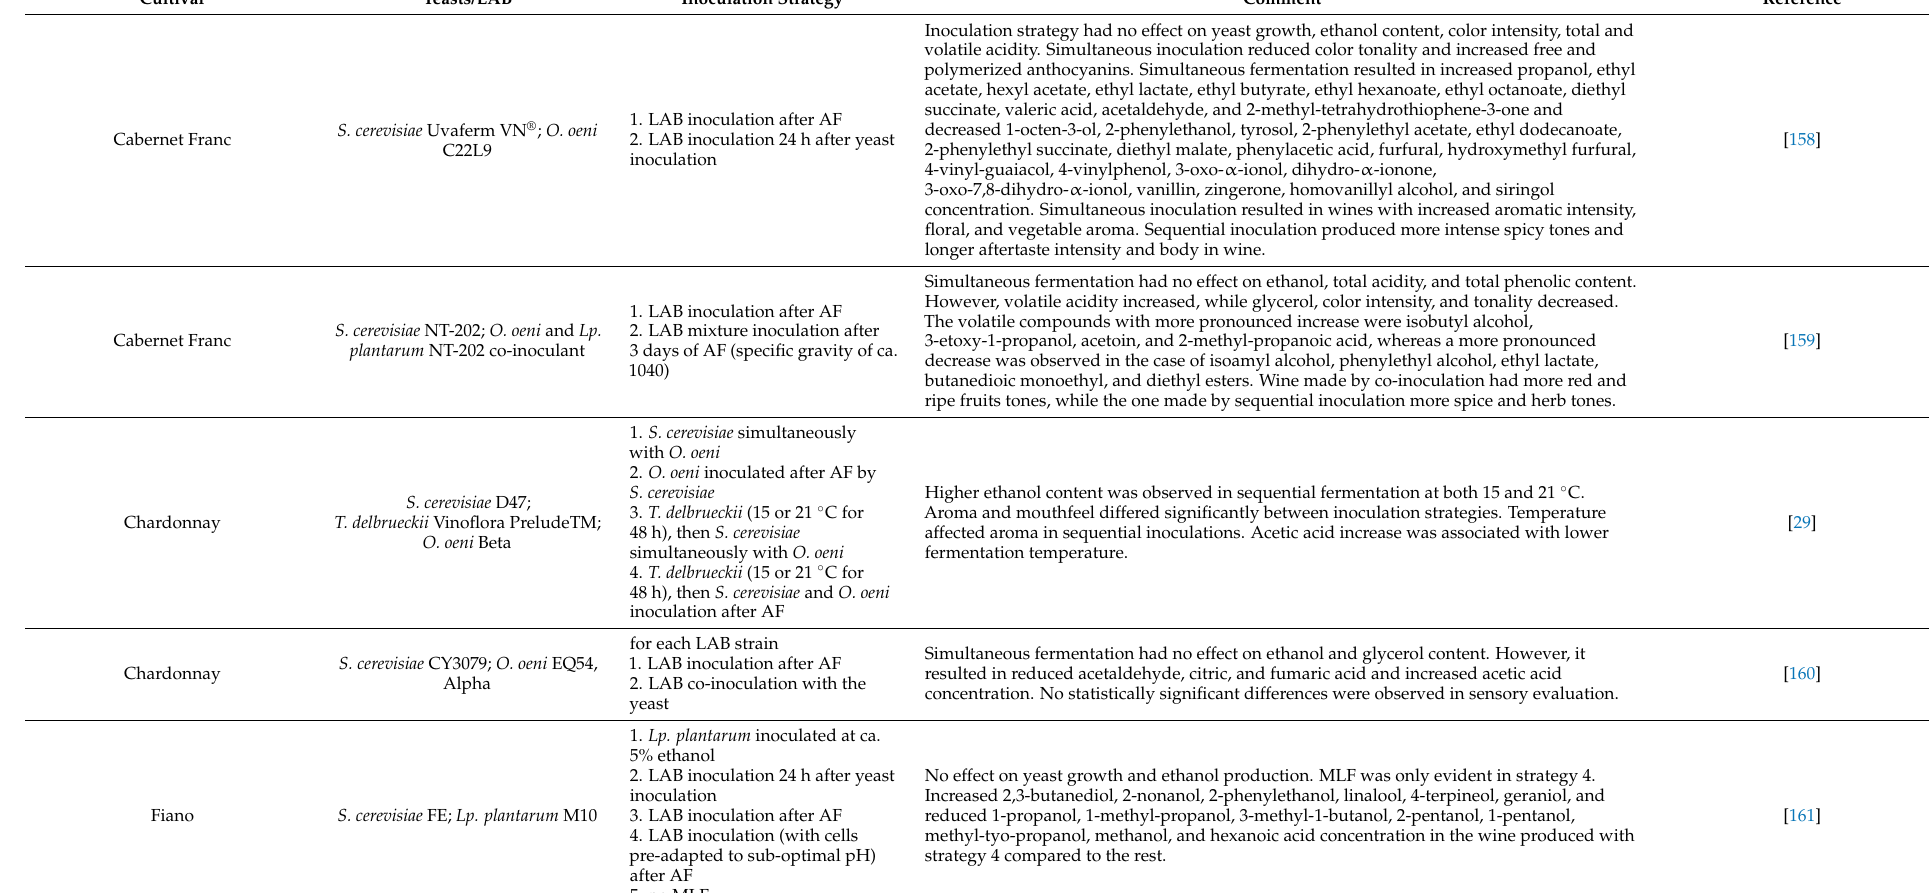
Table 1. Studies that assess the effect of different inoculation strategy on wine